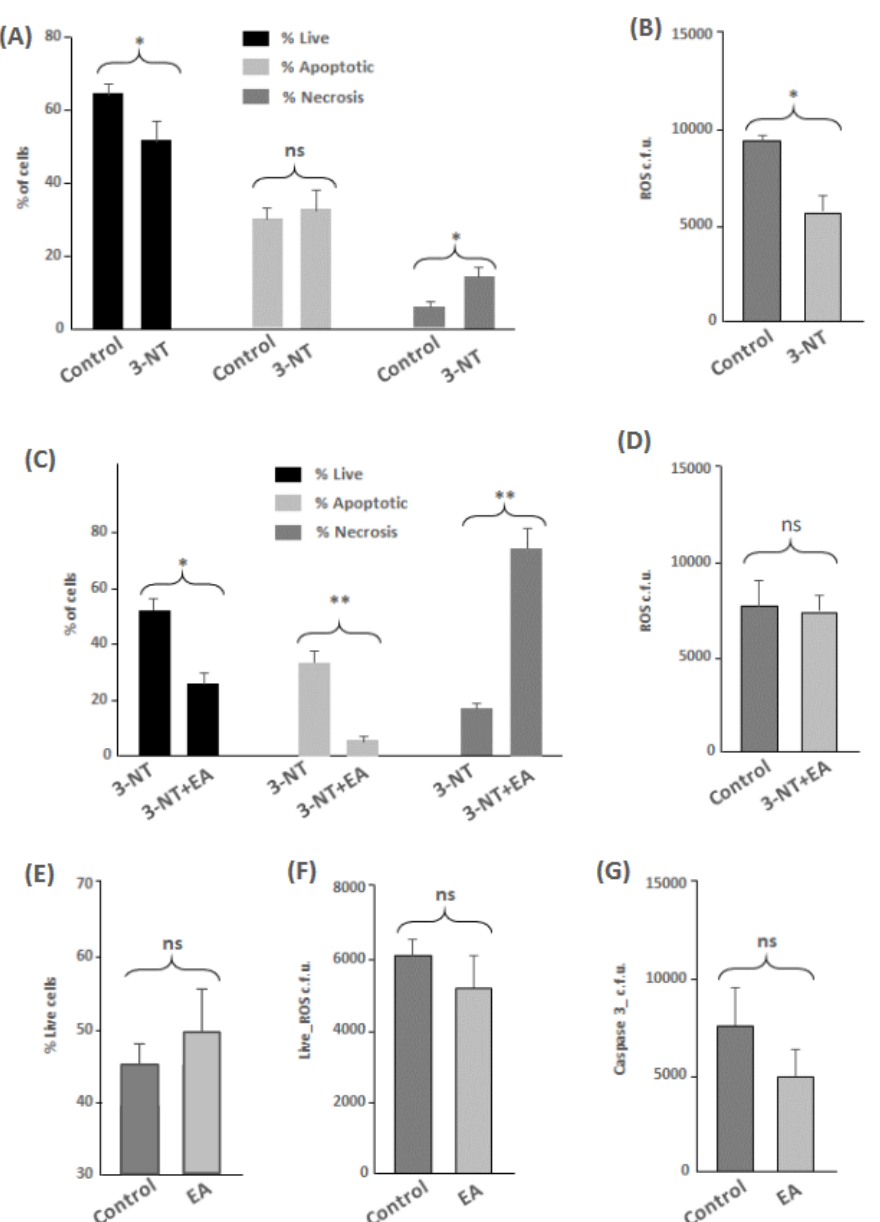
Figure 1. Percentages of live cells (Hoechst +), apoptotic cells (Caspase 3+) and necrotic cells (Ethidium homodimer +) on human enterocytes as affected by exposure to 200 µ M 3-NT for 72 h compared to control counterparts ( A ). Relative fluorescence units (r.f.u.) of ROS occurrence (Cell Rox +) on human enterocytes as affected by exposure to 200 µ M 3-NT for 72 h compared to control counterparts ( B ). Percentages of live cells (Hoechst +), apoptotic cells (Caspase 3+) and necrotic cells (Ethidium homodimer +) on differentiated human enterocytes as affected by exposure to 200 µ M 3-NT+ 200 µ M EA for 72 h compared to 200 µ M 3-NT treated cells ( C ). Relative fluorescence units (r.f.u.) of ROS occurrence (Cell Rox +) on human enterocytes as affected by exposure to 200 µ M 3-NT+ 200 µ M EA for 72 h compared to control counterparts ( D ). Percentages of live cells (Hoechst +) ( E ), relative fluorescence units (r.f.u.) of ROS occurrence (Cell Rox +) (F) and relative fluorescence units (r.f.u.) of apoptotic events (Caspase 3+) ( G ) on human enterocytes as affected by exposure to 200 µ M EA for 72 h compared to control counterparts. Results are expressed as means ± standard deviations. Asterisk on top of bars denote significant differences (* p < 0.05; ** p < 0.01) between paired group of samples (control vs. 3-NT; 3-NT vs. 3-NT). Ns: no significant